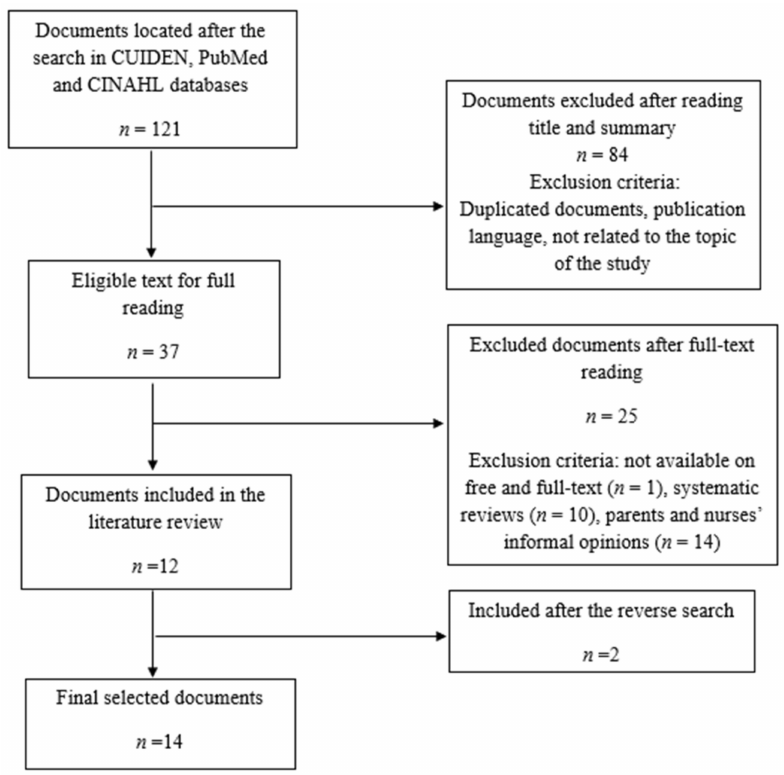
Figure 1. Study selection